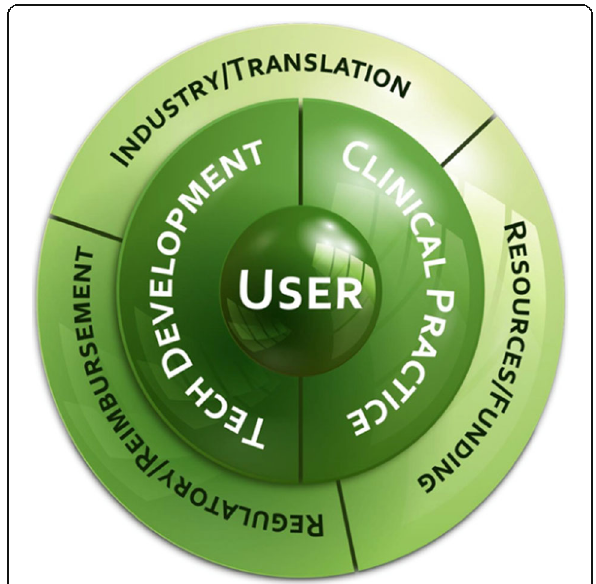
Fig. 1 The relationship between the seven different themes identified in the Cleveland Neural Engineering Workshop meeting. The user/ consumer plays a central